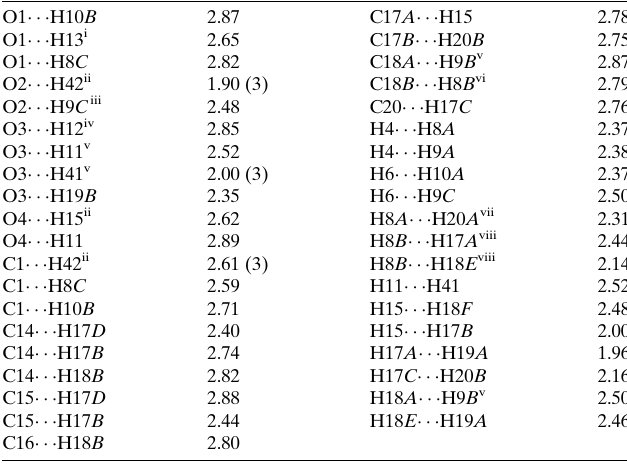
Table 2 Selected interatomic distances (A˚